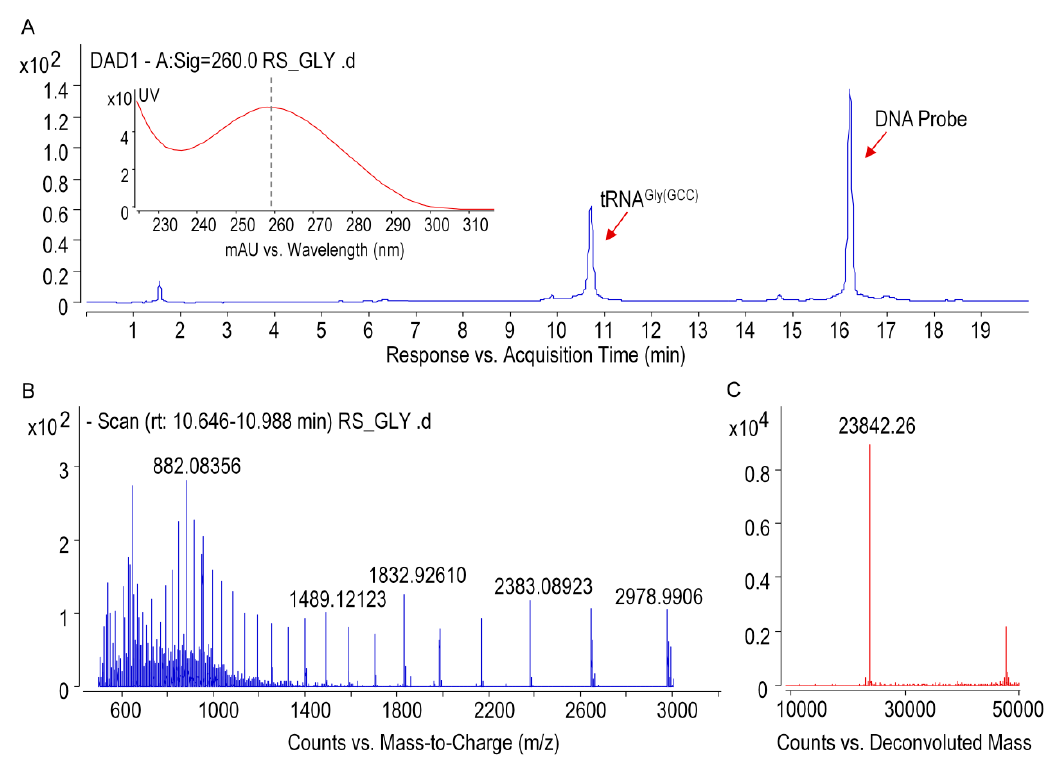
Figure 5. Qualification of purified tRNA Gly(GCC) by using mass spectrometer. ( A ) UHPLC-DAD chromatogram (the inset shows UV-absorption spectrum of tRNA), ( B ) ESI-MS spectra of tRNA Gly(GCC) with multiple negative charges, and ( C ) deconvoluted MS spectra of tRNA Gly(GCC) .